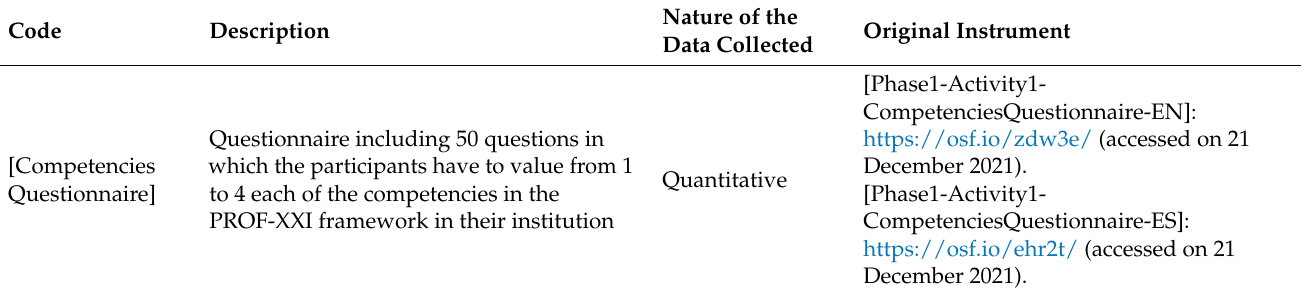
Table 2. Data gathering techniques and